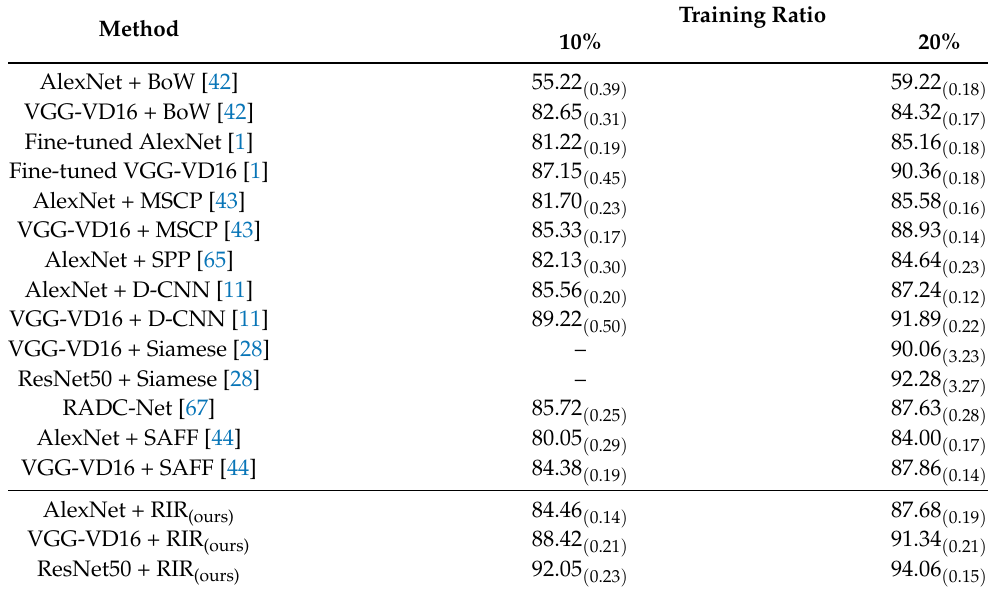
Table 6. Comparison of the classification results (%) on the NWPU dataset (training ratio = 10% and